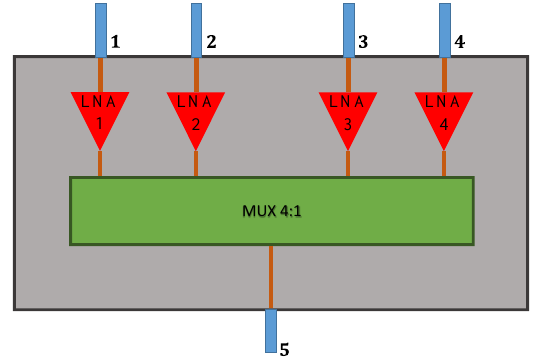
Figure 8. Schematic of the selection stage.